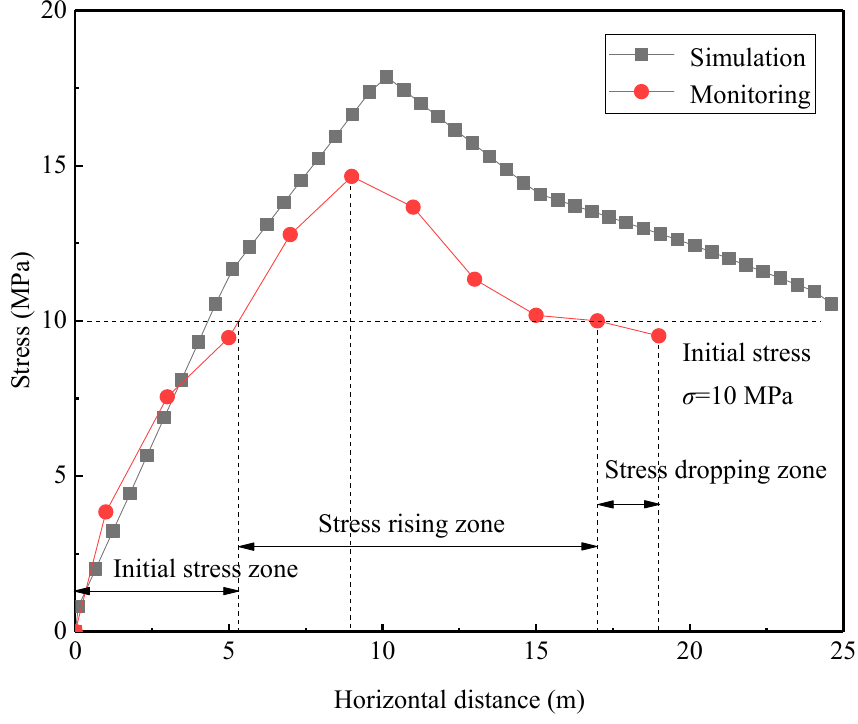
Figure 19. Distribution law of abutment pressure in front of the working face.